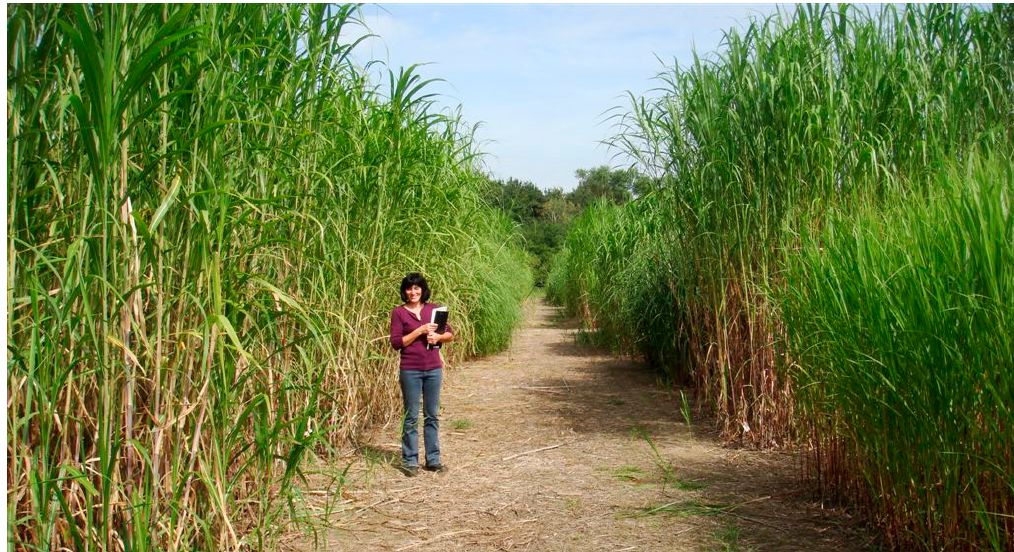
Figure 2. A view of a combined Track 1 and 2 field trial in Braunschweig, Germany in late August 2012 (Photo by Kai Schwarz, with breeding technician, Heike Meyer).